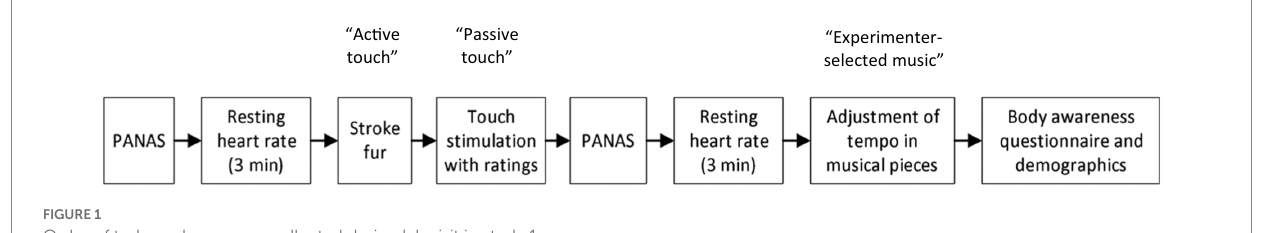
FIGURE 1 Order of tasks and measures collected during lab visit in study